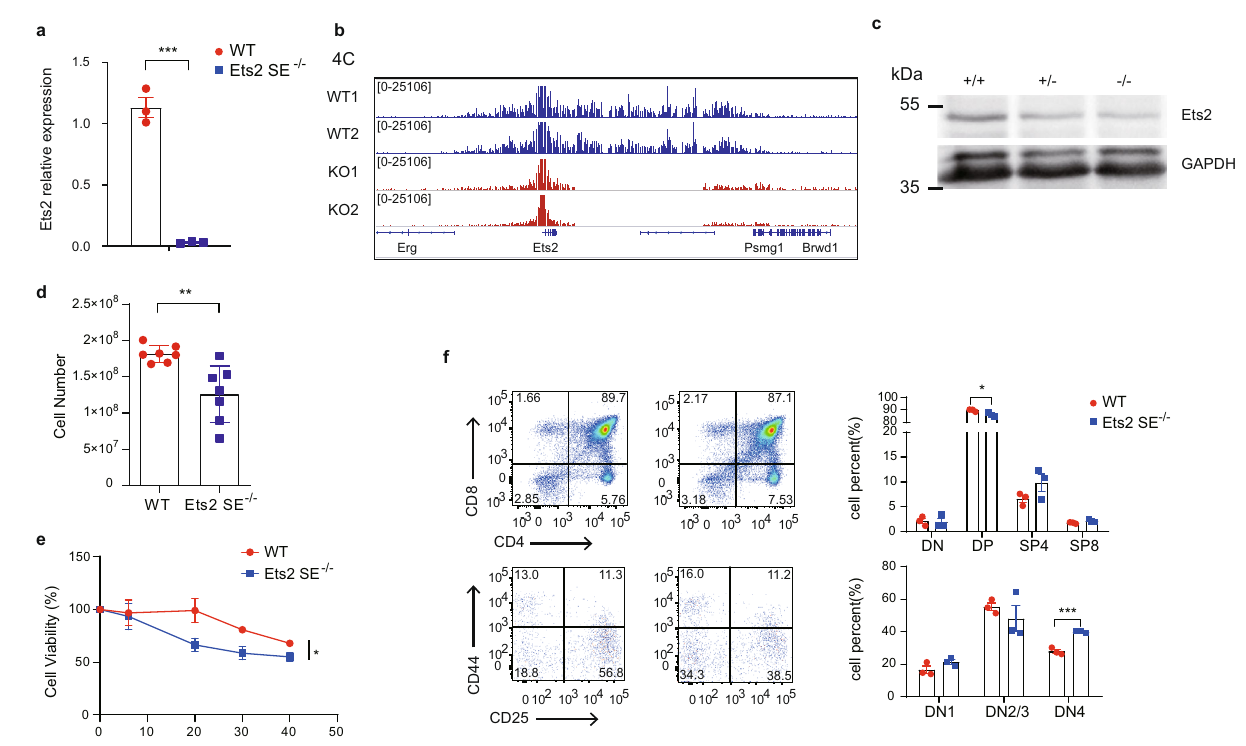
Fig. 6 | Super-enhancer regulates Ets2 expression in the thymus. a Relative Ets2 expressioninthymocytesfrom Ets2 super-enhancerknockout(Ets2-SE − / − )andwild- type(WT)micewasanalyzedusingreverse-transcriptionqPCR.Theexpressionsare normalized to the Actb gene and then to WT. The data represent the mean±SD of three experiments. *** P <0.001 ( P =0.0002) by two-sided Student ’ s t test. b 4C assayfromtheviewpointofthe Ets2 promoterinthymocytesfromWTorEts2-SE − / − mice. The data are presented as reads per million mapped reads (RPM). c Western blot showing Ets2 protein expression in the thymus of WT(+/+), Ets2-SE KO het- erozygous(+/ − ),andEts2-SEKOhomozygous( − / − ).GAPDHwasusedasaninternal control. d Comparisonofwild-typeandEts2-SEknockouttotalthymocytes.Results